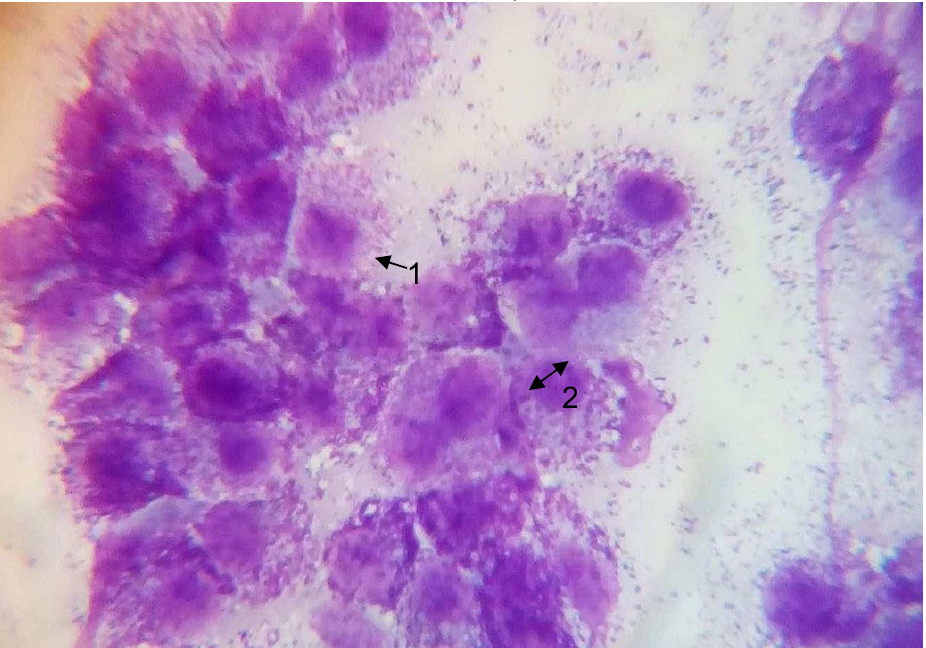
Fig. 3. Cytogram of mastocytoma of high malignancy. Mast cells with a small number of intracytoplasmic granules and slight anisocariasis; nuclear pleomorphism - the presence of non-rounded nuclear forms (1); the presence of dinuclear (2) or multinucleated cells. According to Romanovsky-Gimza. EP. 10, lens